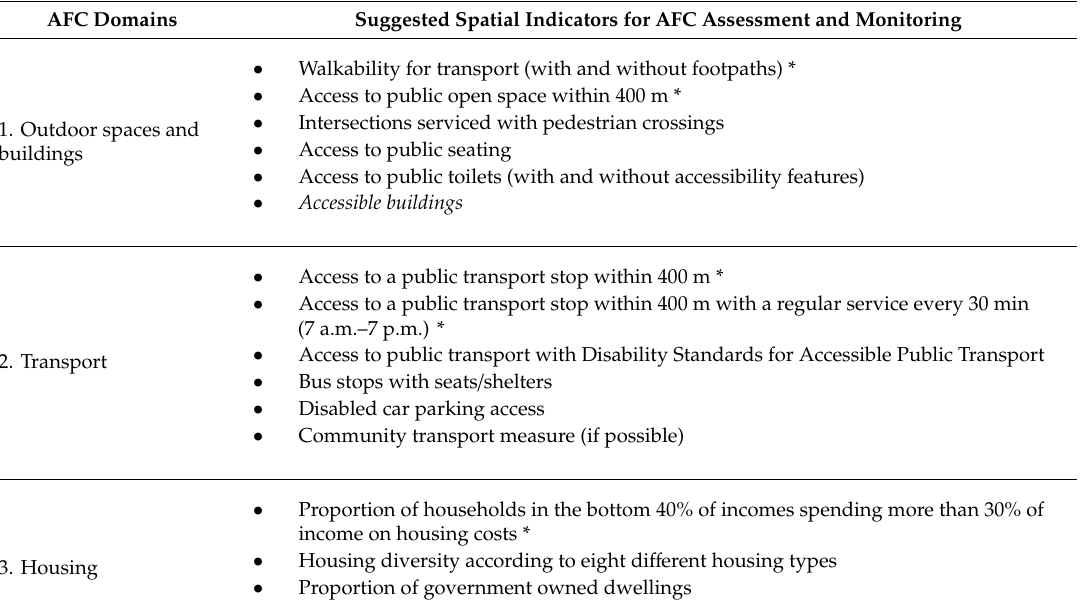
Table 1. Age-Friendly Communities (AFC) domains and suggested spatial